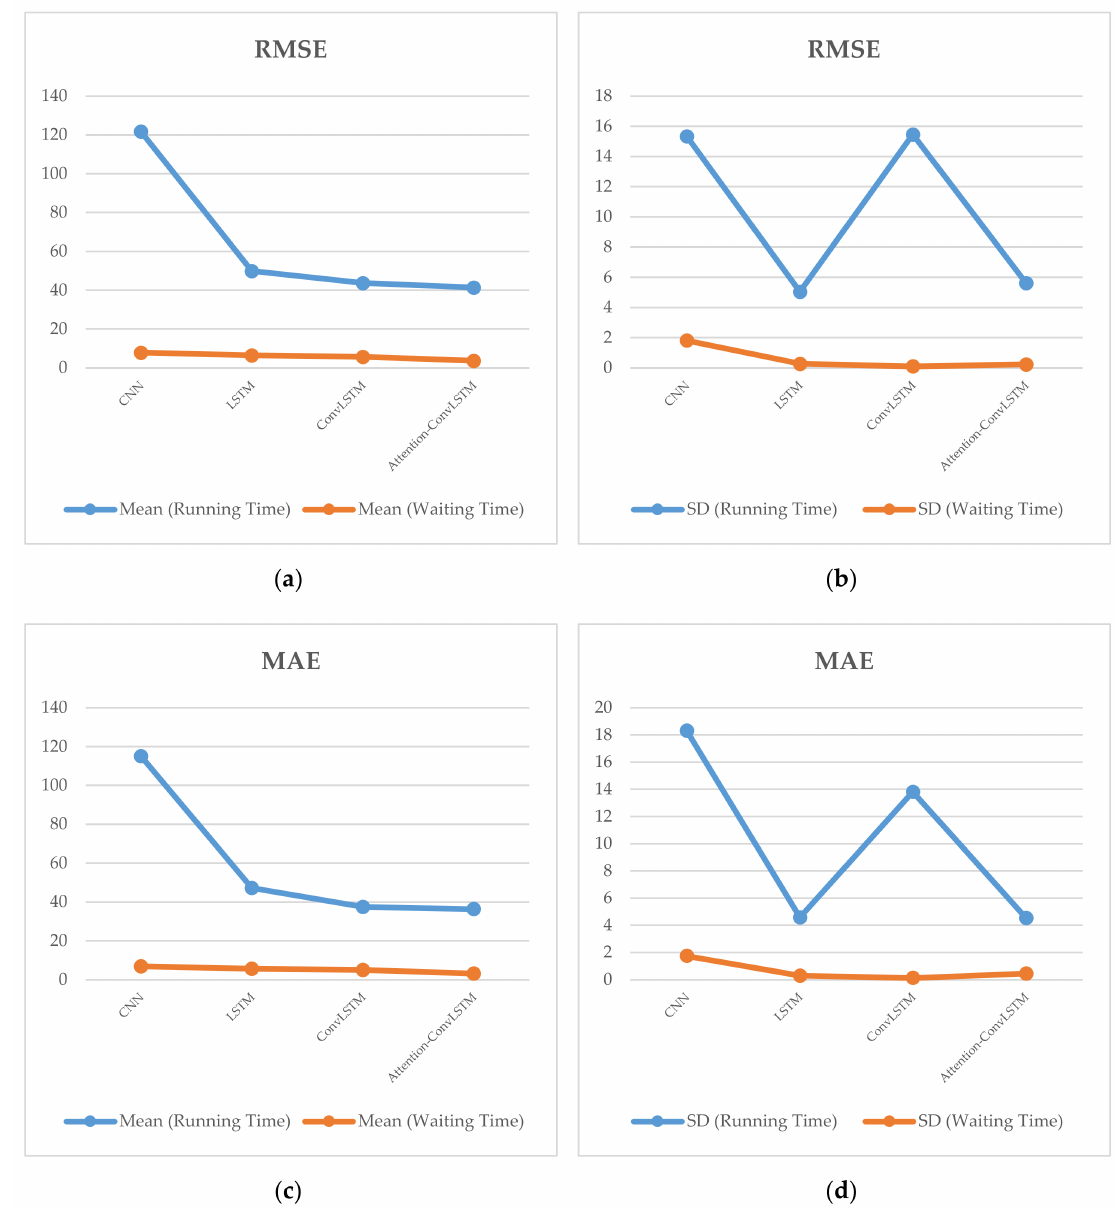
Figure 4. RMSE and MAE for the journey travel time prediction listed as: ( a ) The mean RMSE for the running time and waiting time; ( b ) The standard deviation of RMSE for the running time and waiting time; ( c ) The mean of MAE for running time and waiting time; ( d ) The standard deviation of MAE for the running time and waiting